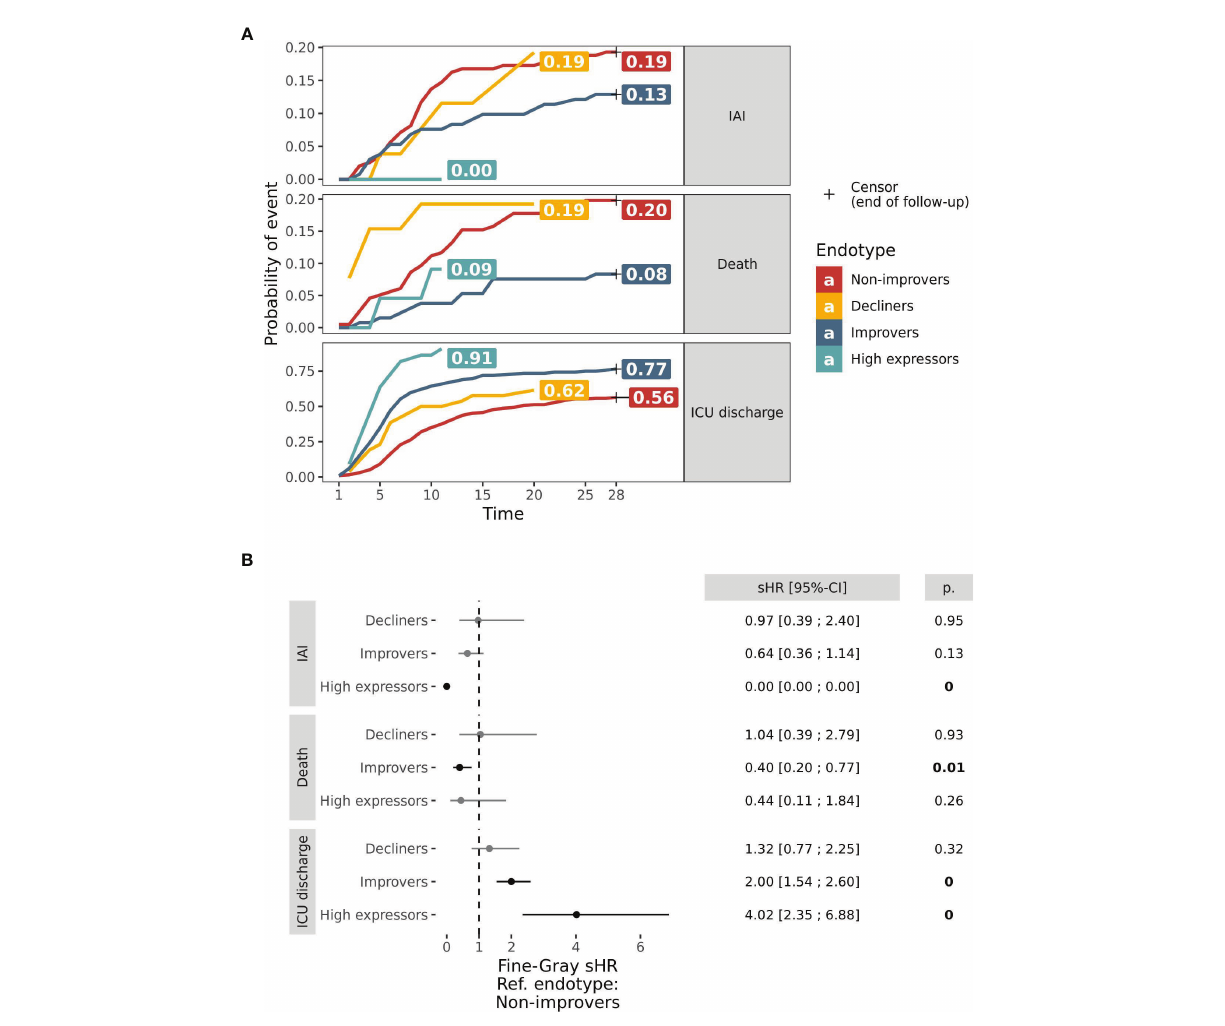
FIGURE 3 | D28 outcomes in mHLA-DR endotypes. (A) Curves of probabilities over 28 days of IAI (top pane), Death (middle pane) and ICU discharge (bottom pane) in Aggregated dataset ’ s endotypes: Non-improvers (red), Decliners (gold), Improvers (dark blue) and High expressors (light blue). These probabilities were estimated through a survival model of IAI with Death and ICU discharge as competing risks and are expressed as cumulated probabilities. Probabilities at the time of the latest remaining patient at risk were reported on the right hand side of curves. (B) Forest plot of Fine-Gray regression sub-distribution Hazard Ratio (sHR) of outcome by endotype, in comparison with Non-improvers. sHR were reported graphically (black point) and numerically along with 95% Con fi dence Interval (CI, horizontal bars). sHR signi fi cantly different from 1 were reported in bold and p value (p.) was numerically